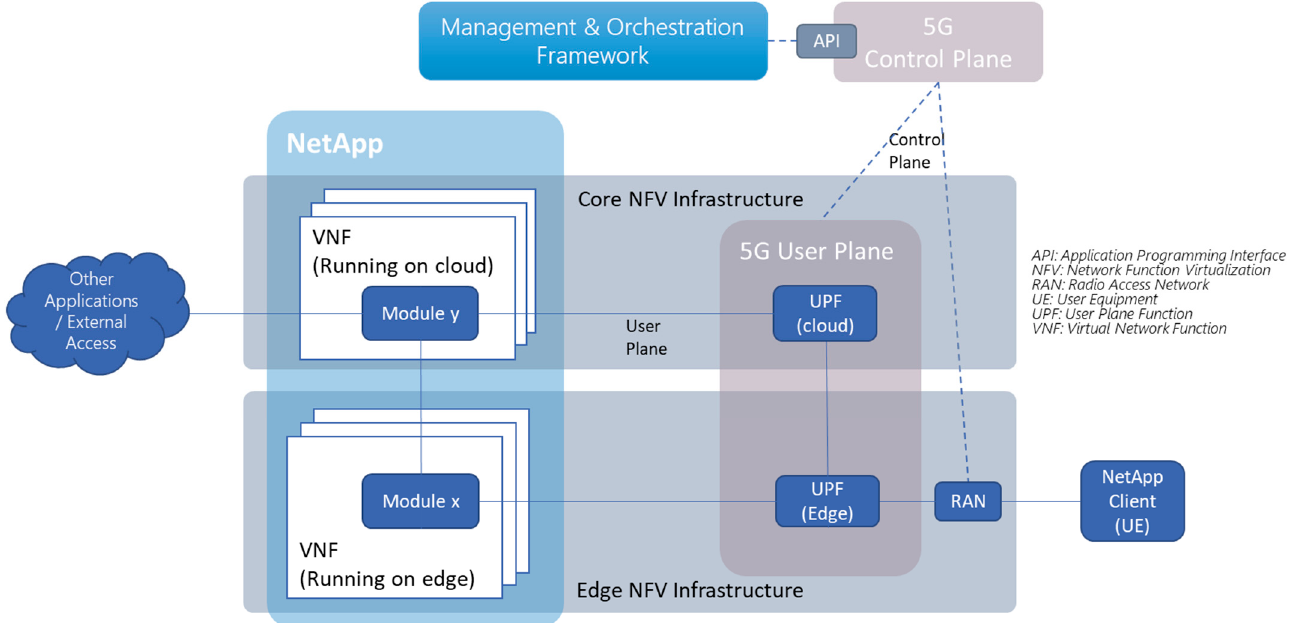
Figure 2. NetApp deployment over a 5G network.